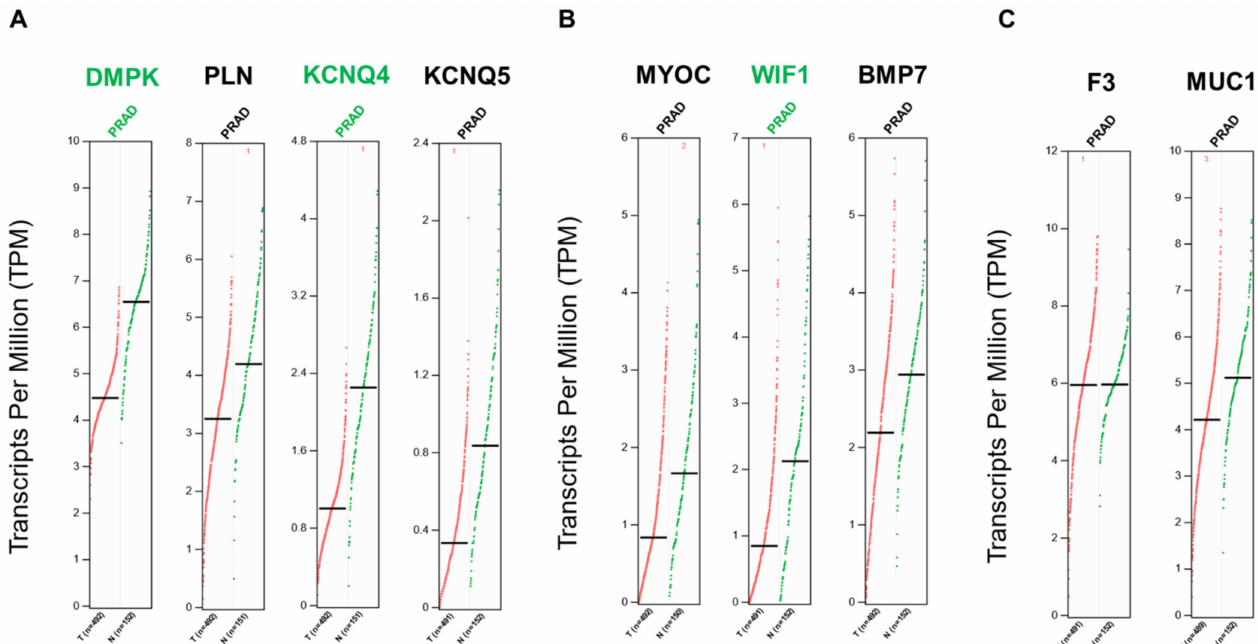
Figure 6. Differential gene expressions of transcripts translated into the membrane and secreted proteins in prostate cancer. ( A )—Genes from downregulated membrane proteins. ( B )—Genes from downregulated secreted proteins. ( C )—Genes from upregulated proteins are commonly present in secreted and membrane proteins. Differential expression levels were calculated using the web based GEPIA tool [40]. GEPIA analysis revealed that genes of the proteins identified were negatively regulated in PRAD. Genes were considered positively or negatively regulated written in red and green, respectively, in PRAD ( n = 489–492) relative to normal tissue ( n = 150–152) when absolute values of fold-change were >1.0 and the q -value < 0.01 (ANOVA). Red dots: indicate prostate cancer tumor samples; green dots: indicate normal prostate